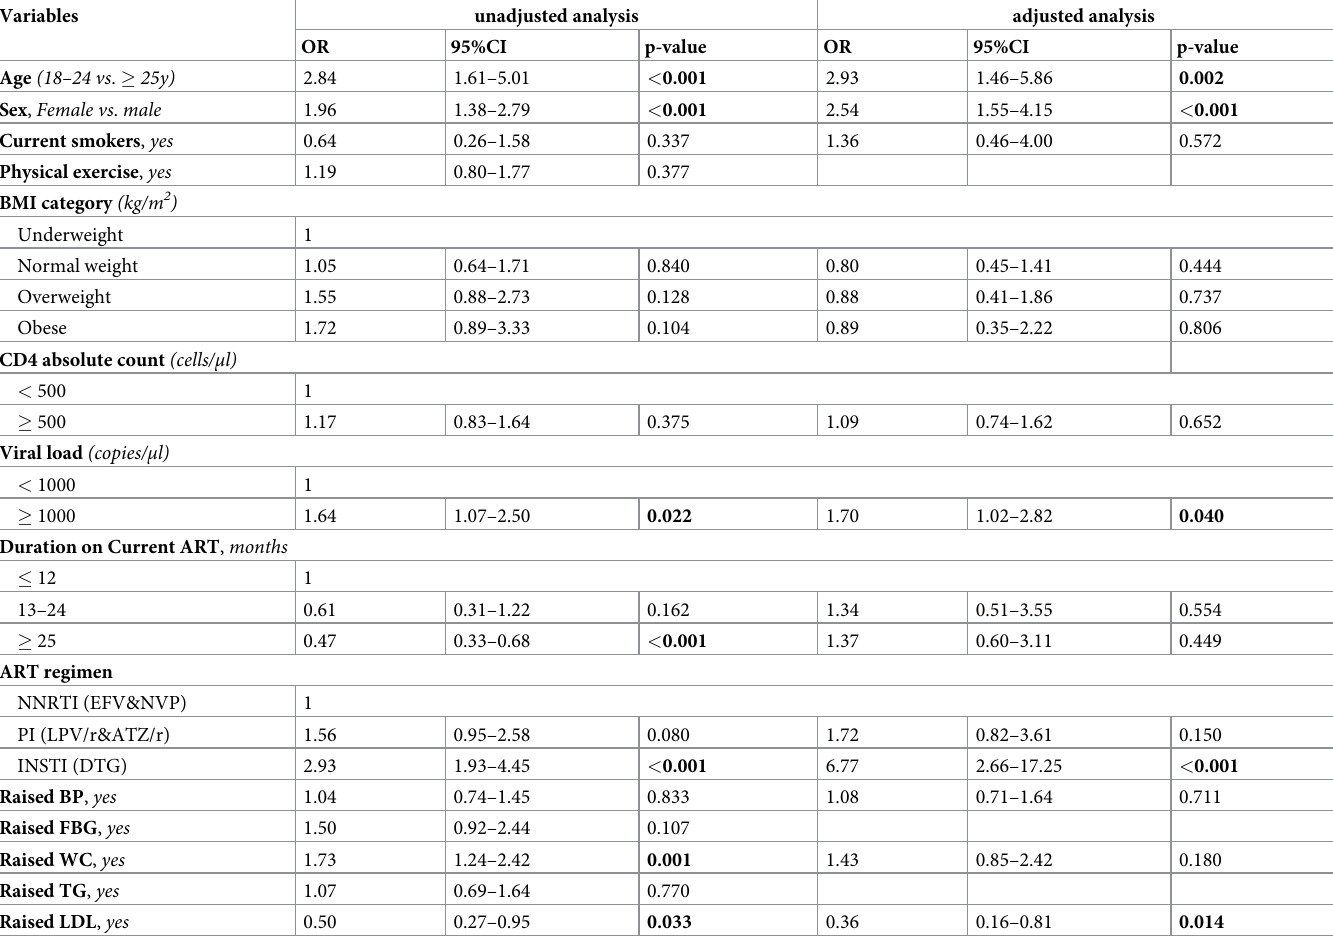
Table 2. Association of low HDL-c with demographic, behavioral and clinical characteristics of study